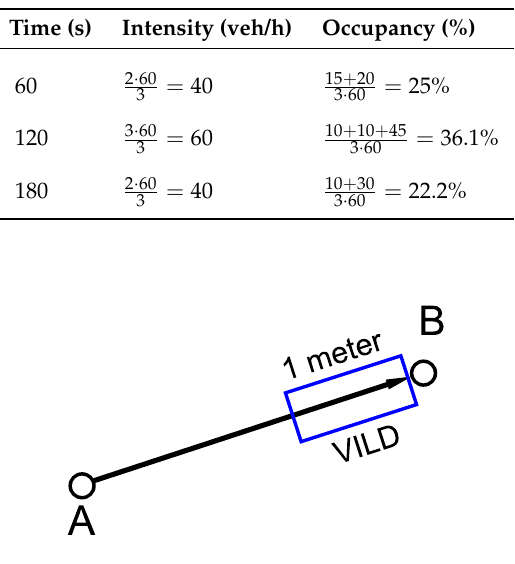
Table 2. Traffic measures from window collector.